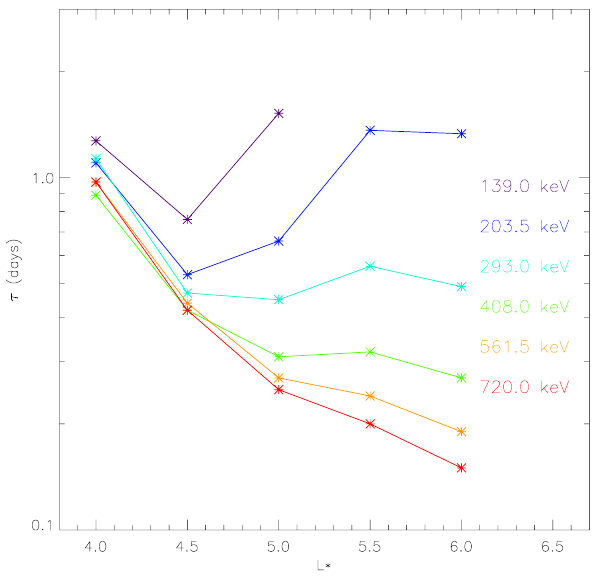
Figure 5. Decay timescales vs. L ∗ for several values of E , deter- mined from the slopes indicated in the previous